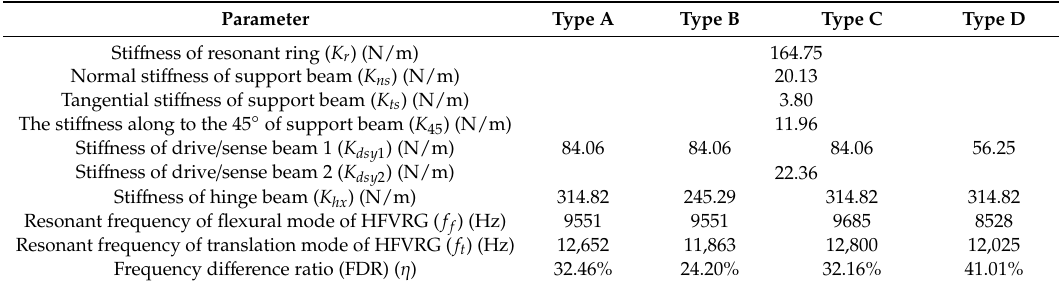
Table 3. Main theoretical sti ff ness and theoretical resonant